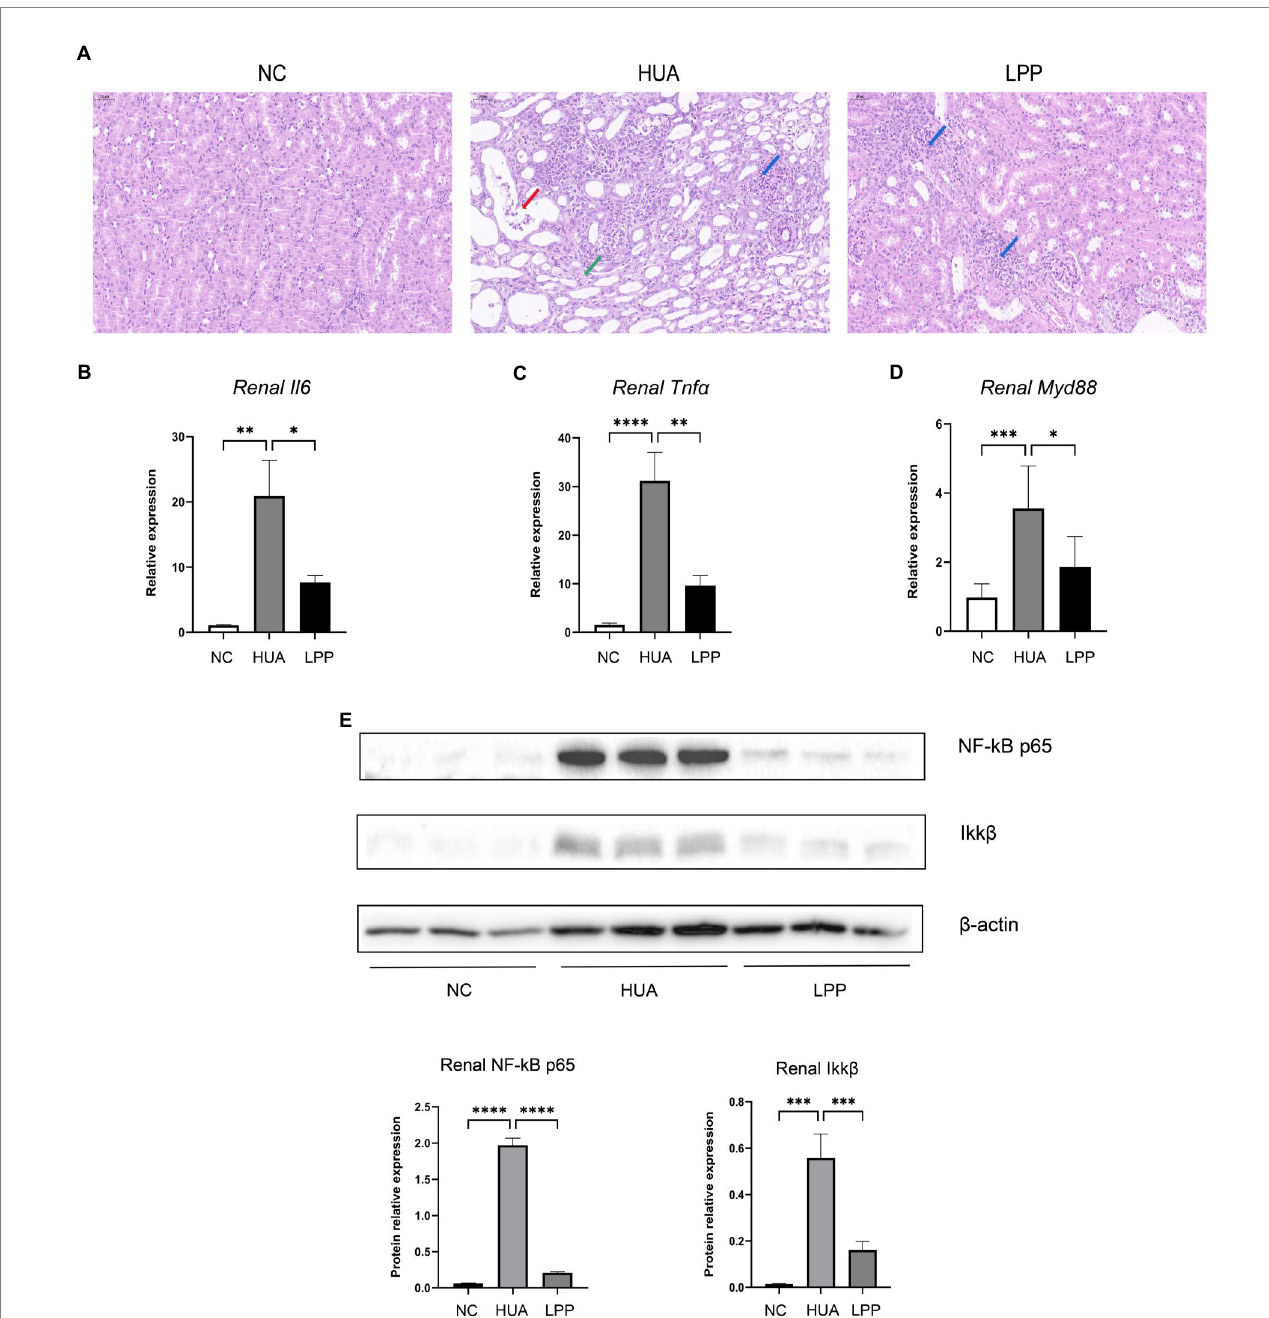
FIGURE 2 Protective effect of LPP on HUA-induced renal inflammation and pathology. (A) H&E stain of renal tissue (200×), red arrow: necrotic cell fragments; green arrow: interstitial fibrosis; blue arrow: inflammatory cell infiltration. (B–D) Quantitative PCR results of Il-6 (B) , Tnfa (C) , and Myd88 (D) relative expression standardized by β -actin ( n = 6 per group). (E) Representative western blotting images of NF-kB p65 and Ikk β in renal tissue. The protein expressions were quantitated by Image J software and normalized by β -actin ( n = 3 per group). Bars are means ± SD, p < 0.05 was set as the threshold for significance by one- way ANOVA followed by post hoc comparisons using Tukey’s test for multiple groups’ comparisons, * p < 0.05; ** p < 0.01; *** p < 0.001; **** p <